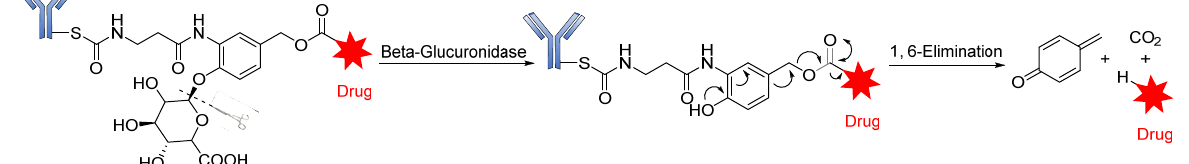
Figure 12. The mechanism by which an ADC containing β -glucuronic acid is released. β -Galactosidase-cleavable linkers